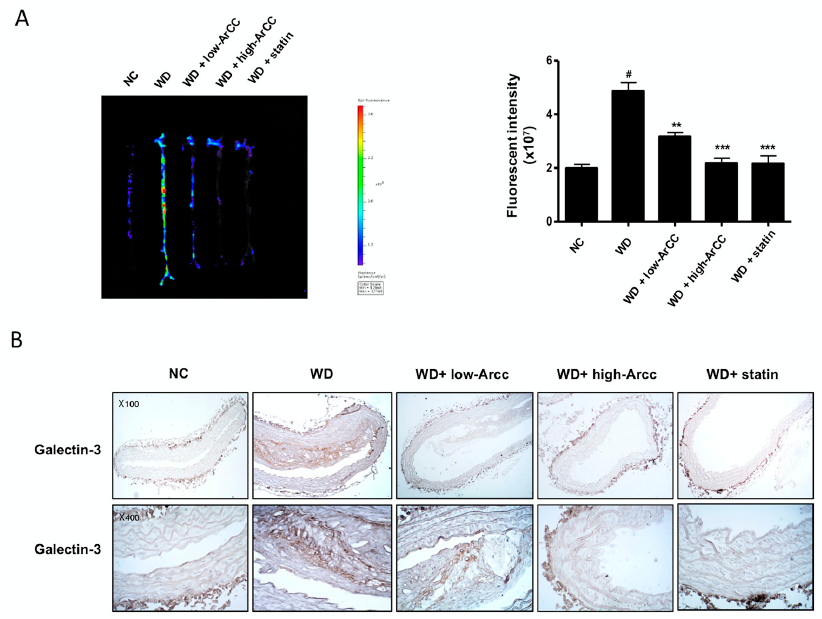
Figure 7. ArCC administration inhibits plaque formation in aortas of WD ApoE − / − mice. ( A ) ApoE − / − mice were injected with ProSense ® 750 EX via tail vein to visualize ex vivo aortic fluorescence imaging. Fluorescence imaging of aortas was quantified using an IVIS ® Lumina XRMS (X-ray multi-species optical imaging system) and analyzed by Living Image Software 4.4 (PerkinElmer). High signal intensities are shown in red/yellow/green/blue (Color scale). # p <0.05 versus NC; ** p <